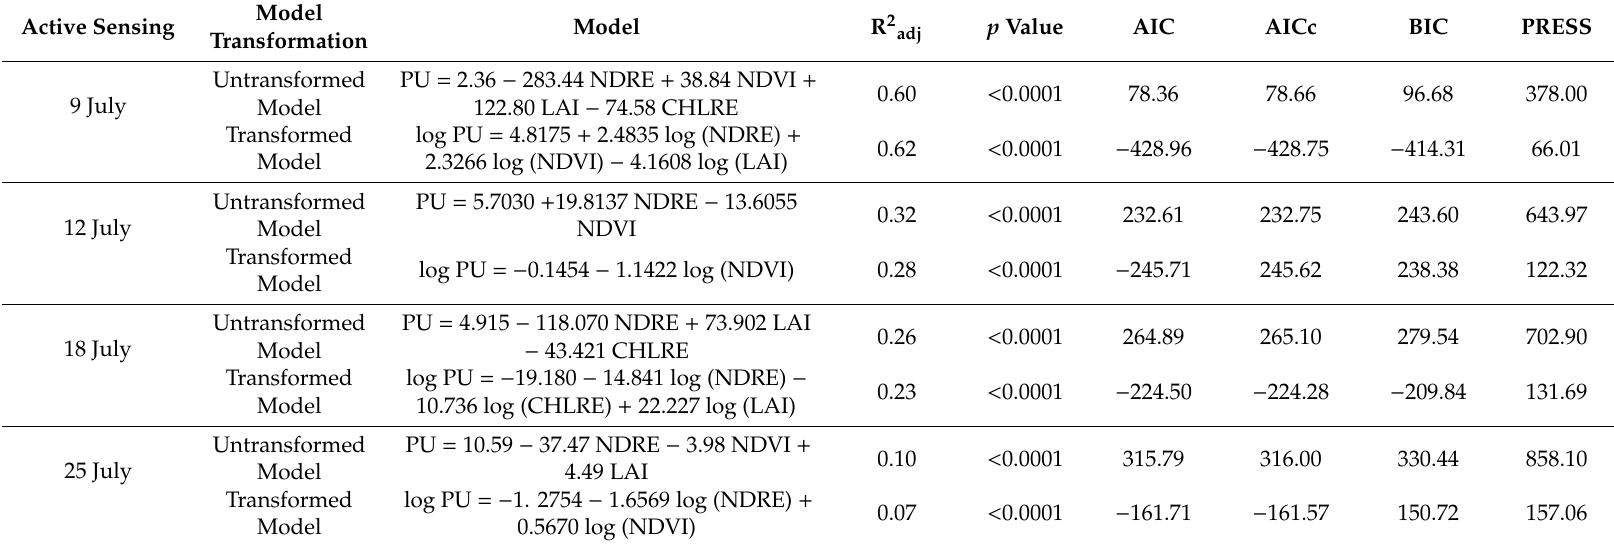
Table 5. Phosphorus uptake (kg ha − 1 ) models with adjusted coe ffi cients of determination (R 2 adj ), p Value, AIC, AICc, BIC, and PRESS for Crop Circle ™ . Active